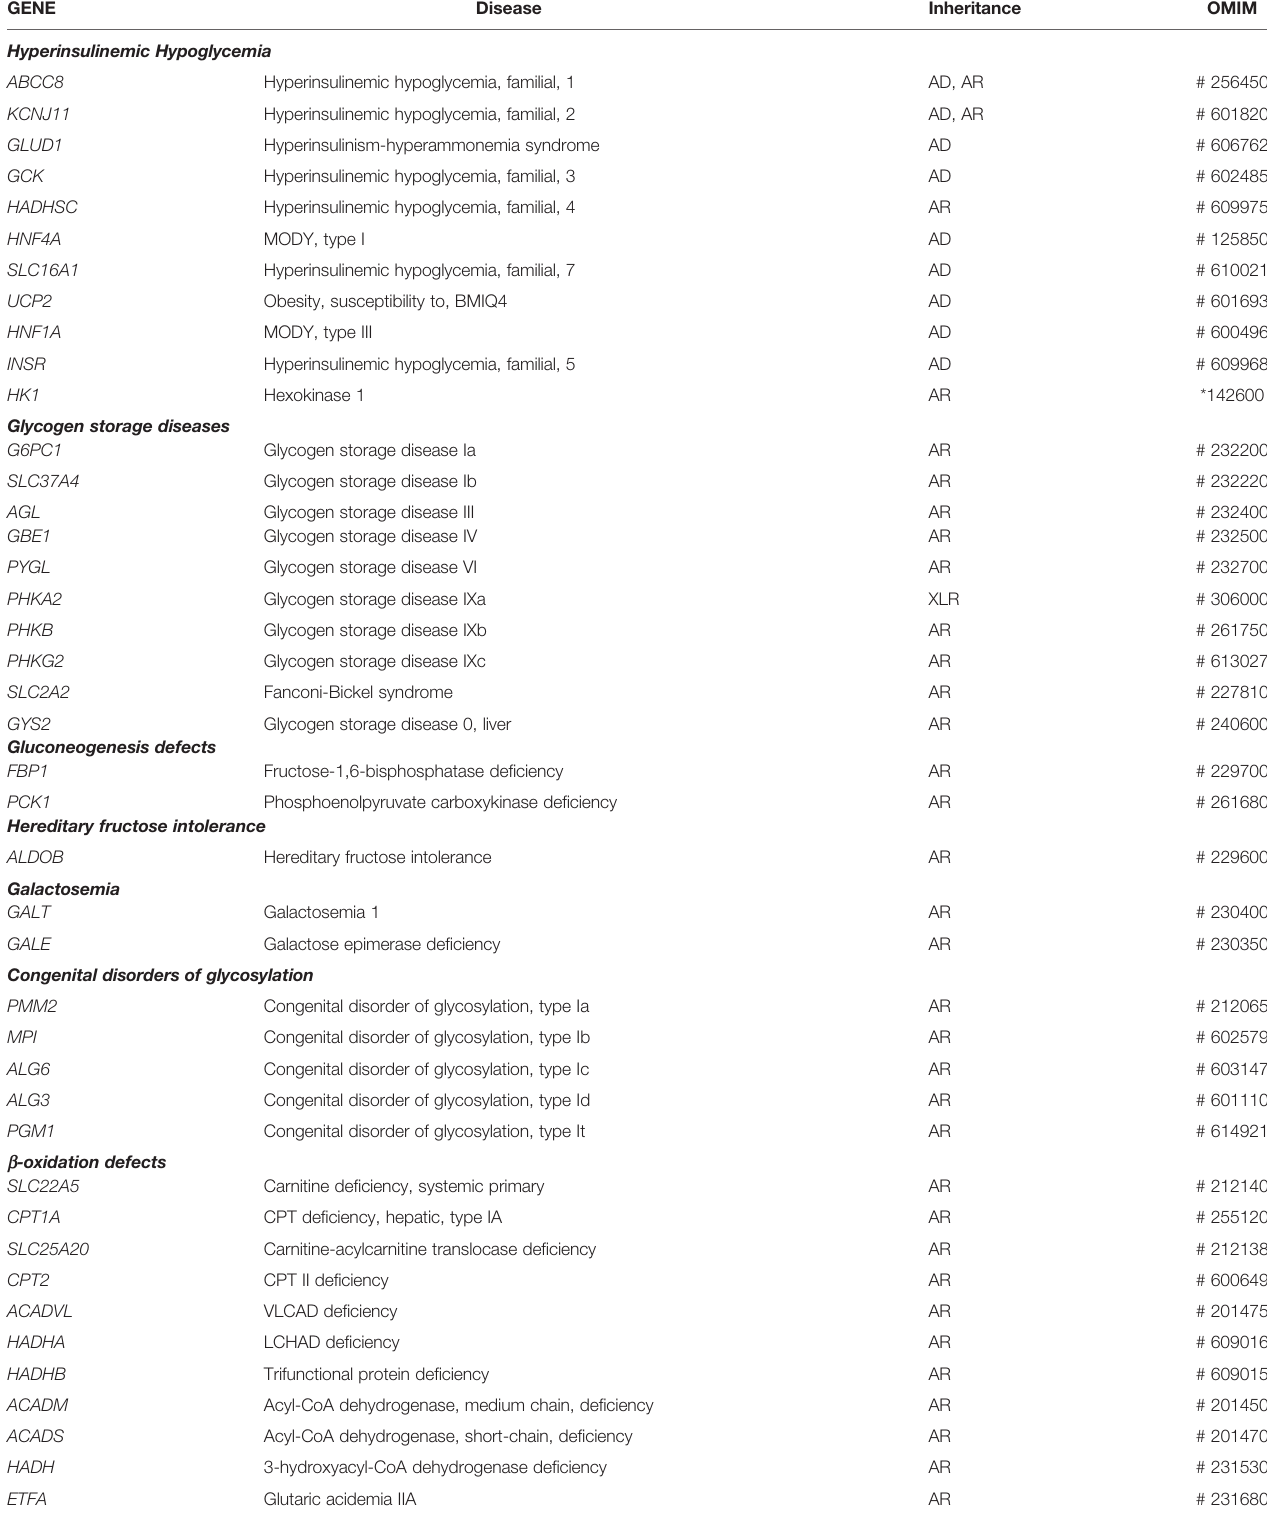
TABLE 1 | Genes associated to Hypoglycemia.